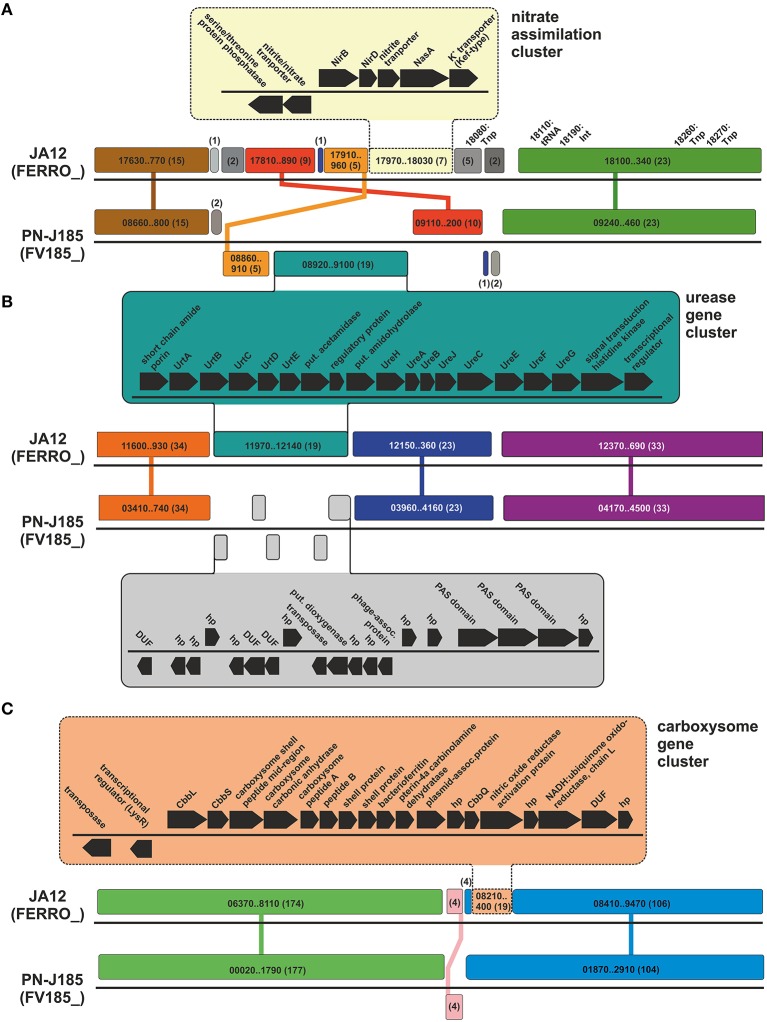
Homologous genome regions in the group 2 strains JA12 and PN-J185 involved in nitrate assimilation (A), urea utilization (B) and carboxysome formation (C). Conserved segments (collinear blocks) were predicted using Mauve (Darling et al., 2010). Collinear blocks between both genomes are shown in the same color and are connected by lines. Locus tags (JA12: FERRO_; PN-J185: FV185_) and number of genes (in parentheses) is given for the collinear blocks. Selected regions containing the nitrate assimilation gene cluster (A), the urea gene cluster (A: PN-J185; B: JA12) and the carboxysome gene cluster (C) are shown in more detail. Nitrite reductase, NirBD; nitrate reductase, NasA; transposase, Tnp; integrase, Int; urea ABC transporter, UrtABCDE; urease, UreABC, urease accessory proteins, UreHJEFG; hypothetical protein, hp; proteins containing a domain of unknown function, DUF; RuBisCO, CbbLS; RuBisCO activating protein, CbbQ.